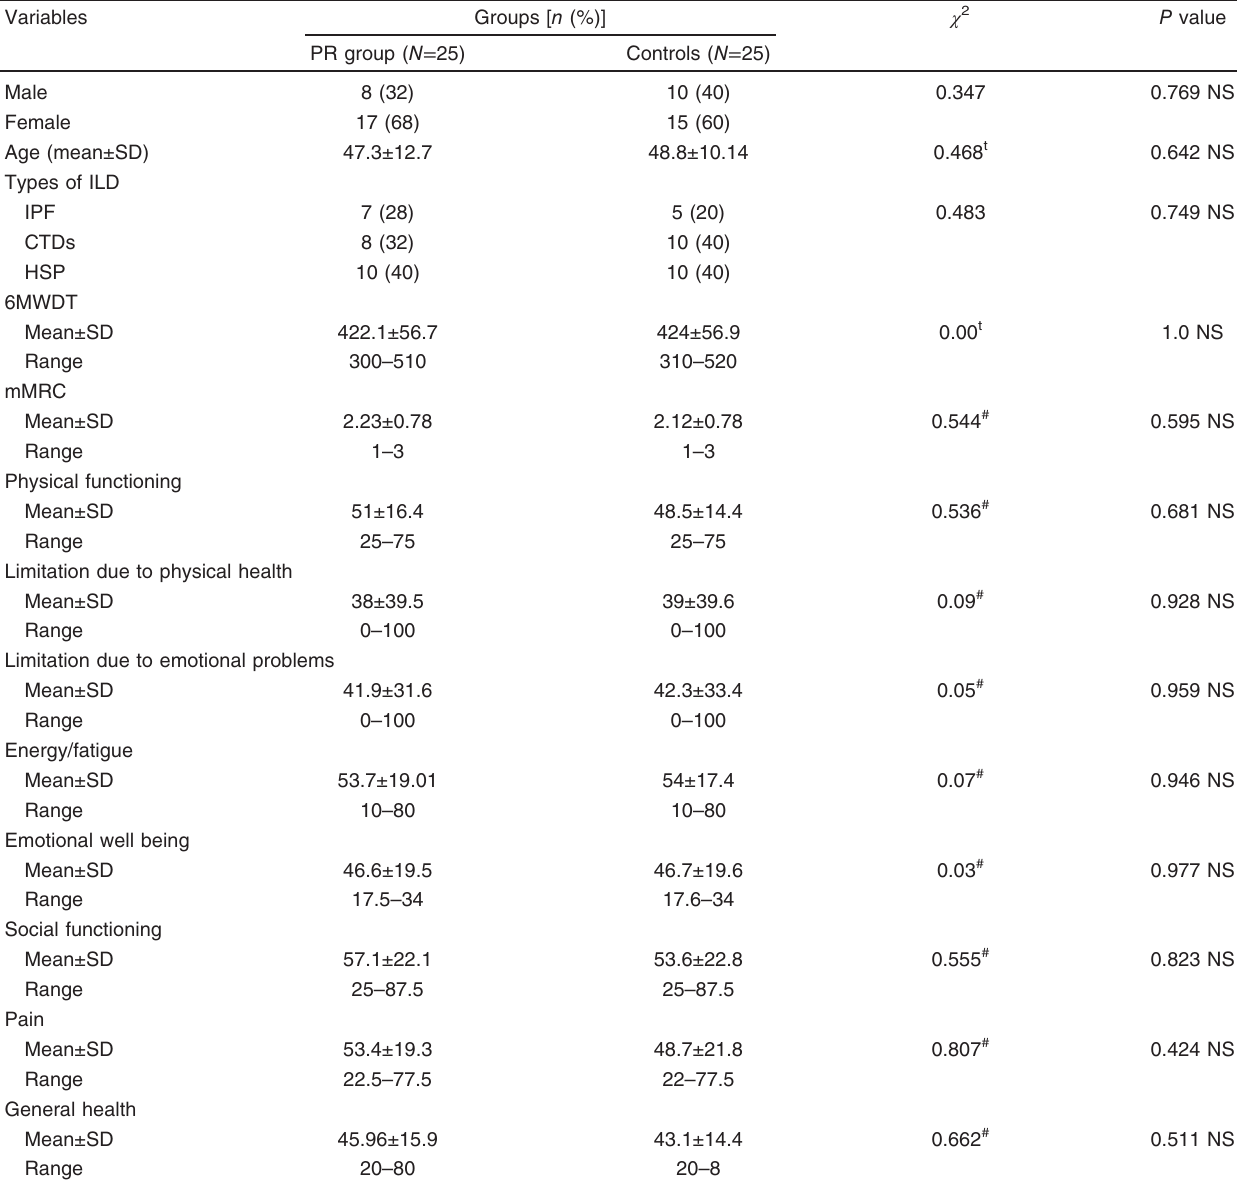
Table 1 Baseline data of the studied population and prepulmonary rehabilitation health status evaluation by short-form health survey questionnaire, exercise by 6min walk distance and dyspnea by modified Medical Research Council Variables Groups [ n